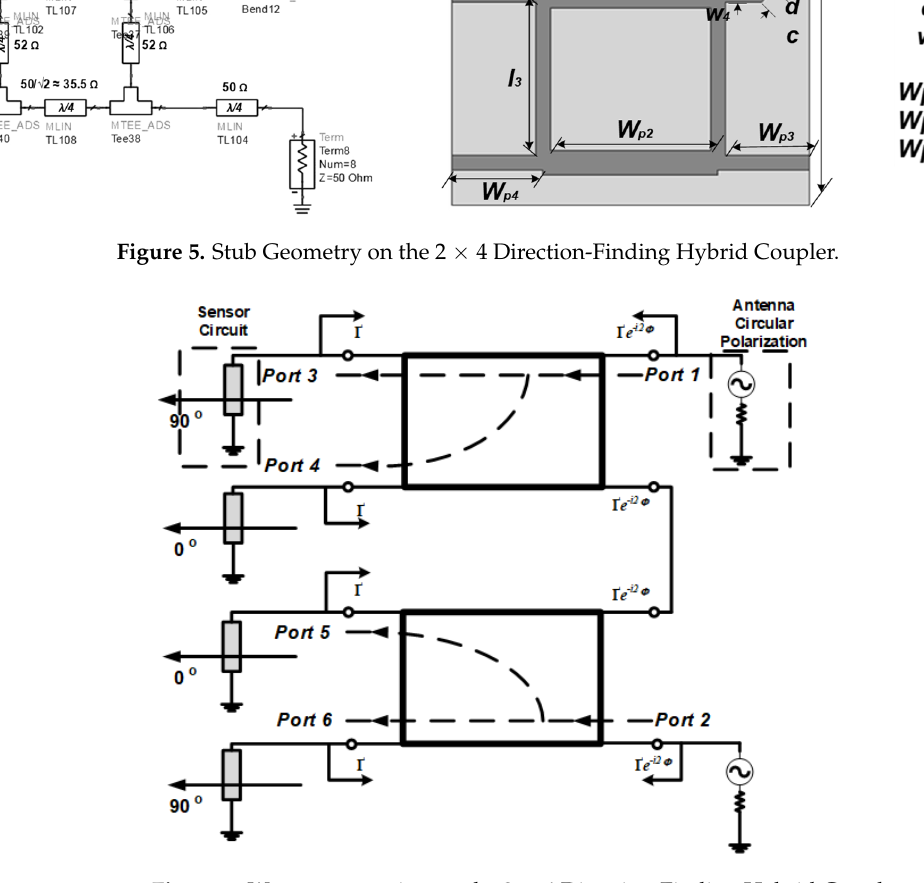
Figure 5. Stub Geometry on the 2 × 4 Direction-Finding Hybrid Coupler.